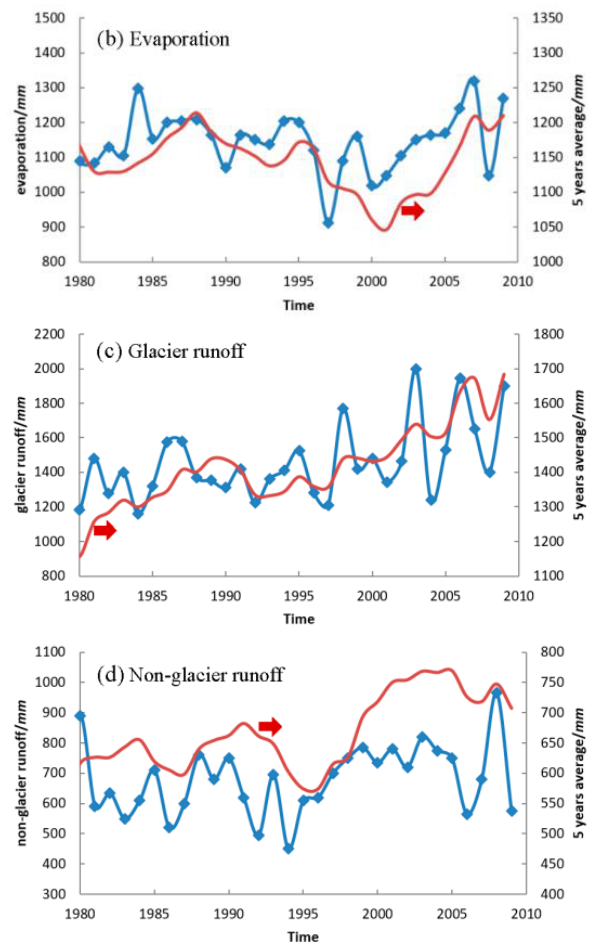
Figure 4. Time series for precipitation ( a ); evaporation ( b ); glacier runoff ( c ); and non-glacier runoff ( d ) in Nam Co Lake from 1980–2009.